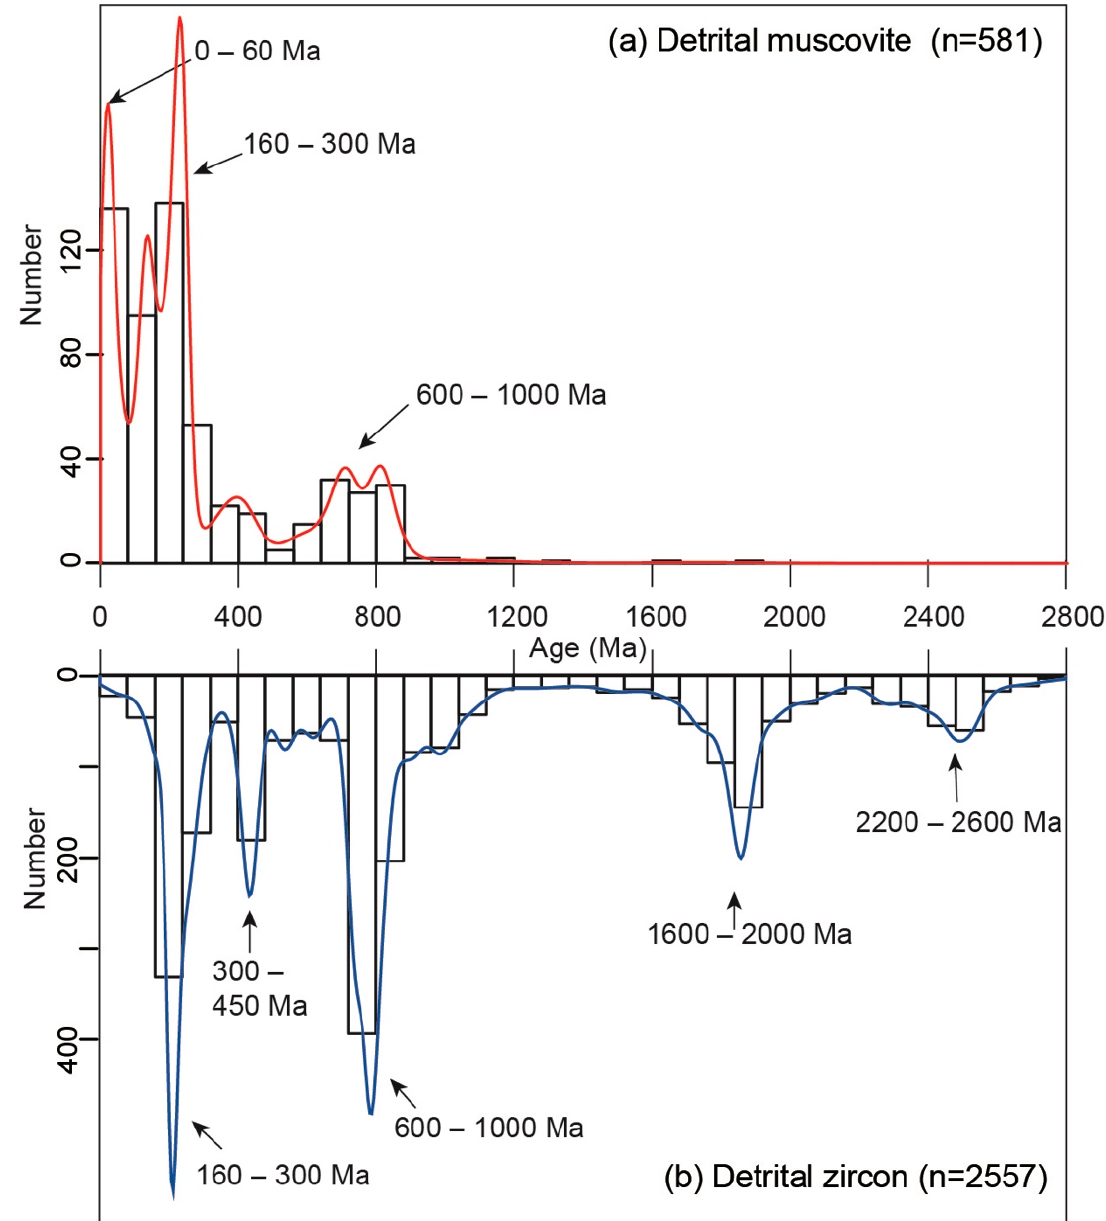
Figure 3. Probability density diagrams for pooled detrital muscovite 40 Ar / 39 Ar ( a ) and zircon U-Pb ( b ) ages of the Yangtze River basin. Detrital zircon data from He et al. [21] and Yang et al. [26]. Detrital muscovite data from Sun et al. [16,24,35] and Hoang et al. [25].